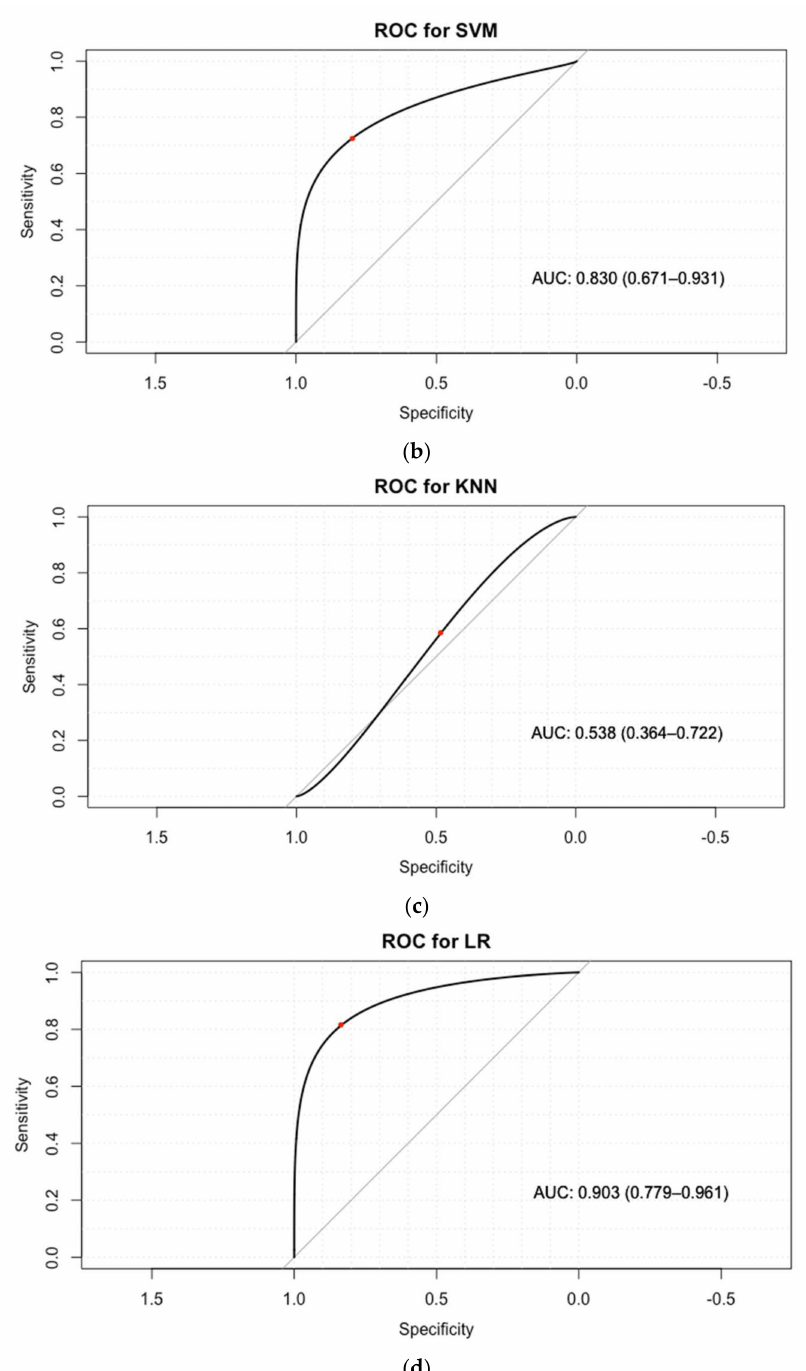
Figure 4. Receiver open characteristics (ROC) curves and measured area under curve (AUC) obtained for the test set of ( a ) Random forest; ( b ) Support vector machine; ( c ) k -Nearest Neighbour; ( d ) Logistic